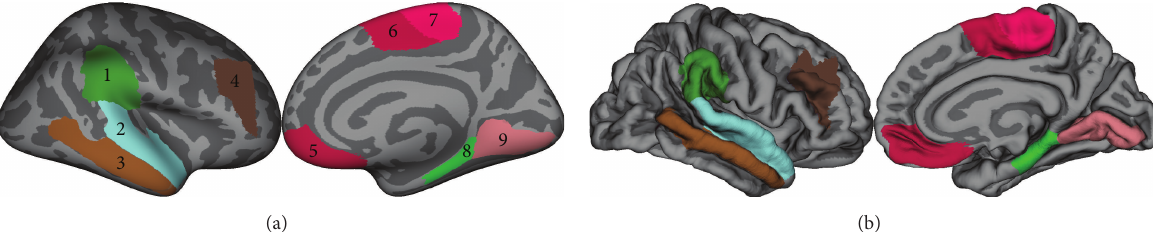
Figure 1: Cortical regions discussed in the present review. Cluster nr 1: supramarginal gyrus; 2: superior temporal gyrus; 3: middle temporal gyrus; 4: dorsolateral prefrontal cortex (DLPFC); 5: ventromedial prefrontal cortex (VMPFC); 6: presupplementary motor area (pre-SMA); 7: supplementary motor area (SMA); 8: parahippocampal gyrus; 9: lingual area. Regions were drawn on the fsaverage subject in FreeSurfer 5.3 based on the Desikan atlas [82]. An inflated right hemisphere is presented (a) and the version outlining the gyri and sulci (b). SMA and pre-SMA were drawn based on the Brodmann atlas in FreeSurfer. The DLPFC region was drawn over Brodmann areas 9 and 46 [83] with the dorsal and ventral borders at the bottom of the superior and inferior frontal sulci, rostral border at the anterior termination of the olfactory sulcus [84], and the caudal border at the limit of Brodmann areas 8 and 9 [83]. Image created with GIMP Image Manipulation Program